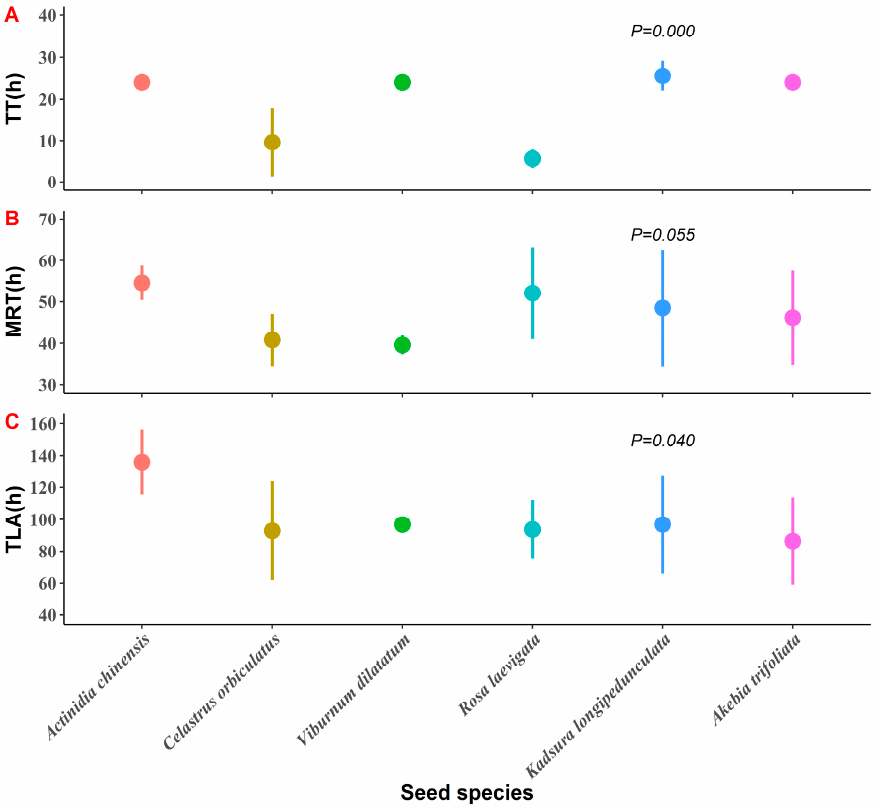
Figure 2. Relationships between seed species and three passage time parameters: ( A ): time of the first appearance of a seed (TT); ( B ): mean retention time (MRT); ( C ): time of the last appearance of a seed (TLA). The dots represent the mean and the bars show the standard deviation (SD).